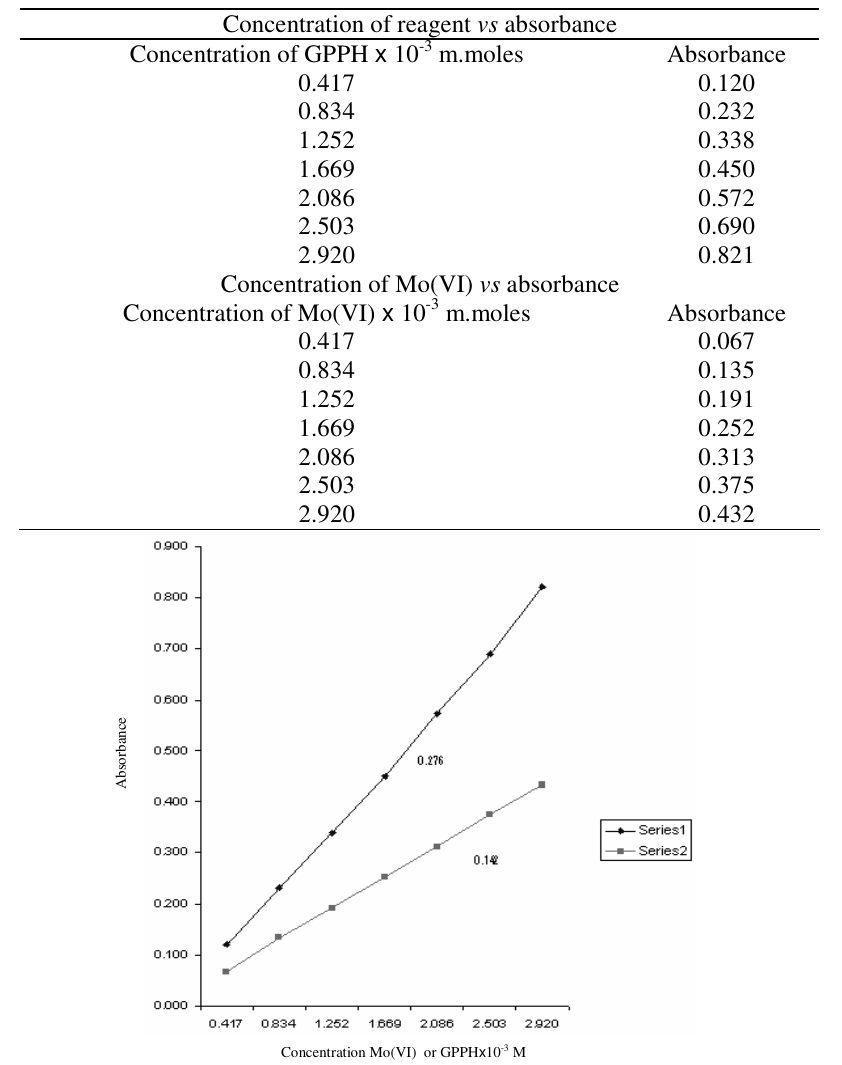
Table 4 . Slope ratio method for the determination of composition of Mo(Vi)-GPPH complex